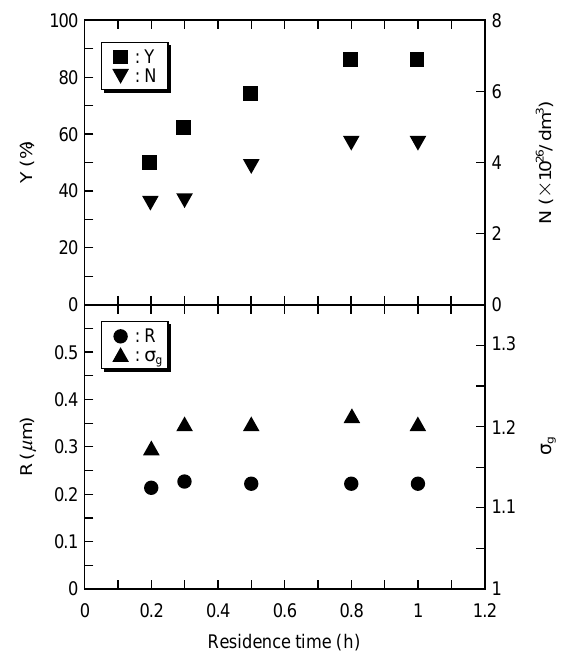
Dependence of particle size, σ g , yield, and particle number density on residence